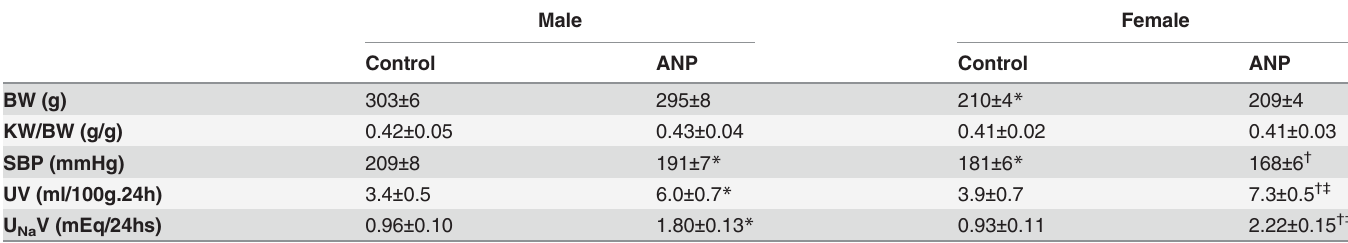
Table 1. Effect of chronic treatment with ANP on blood pressure, kidney weight, diuresis and natriuresis in SHR of both sexes. Male Female Control ANP Control